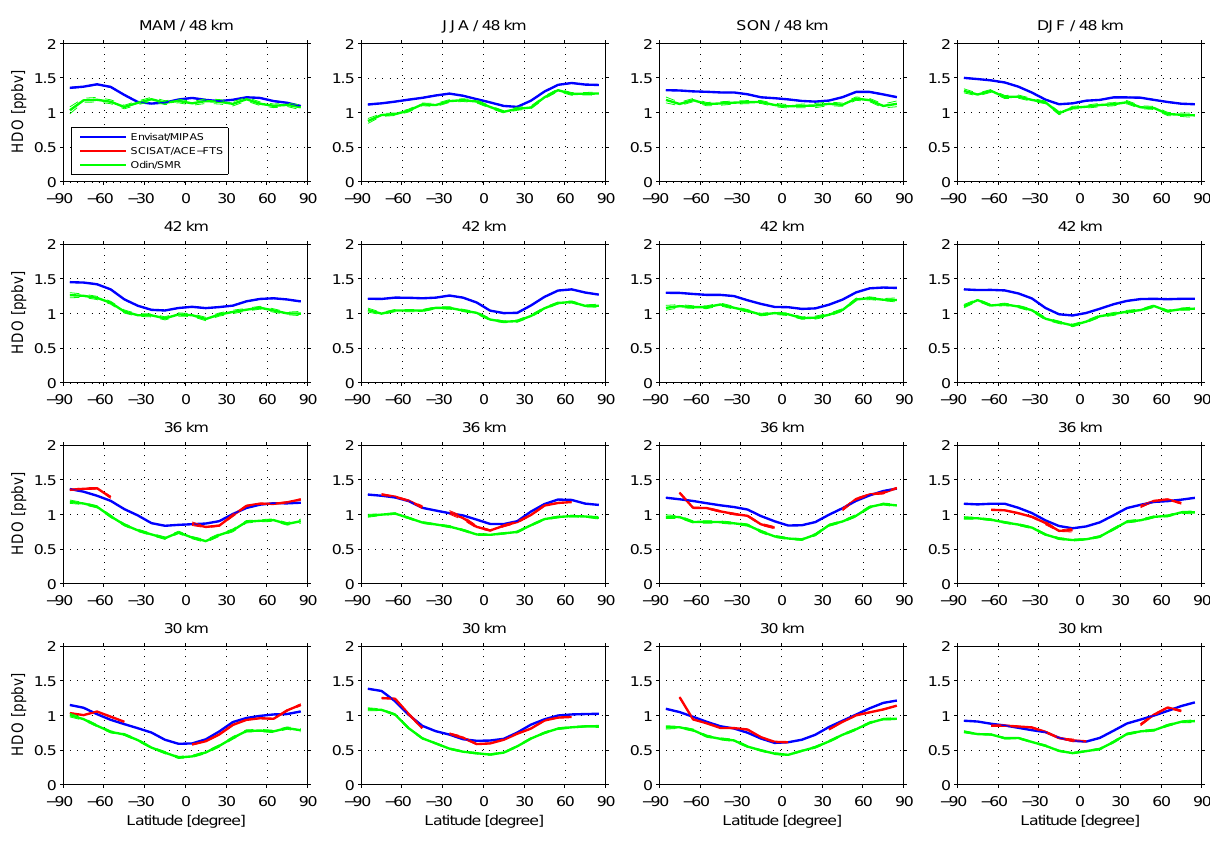
Fig. 4. As Fig. 3 but here for the altitudes from 30km to